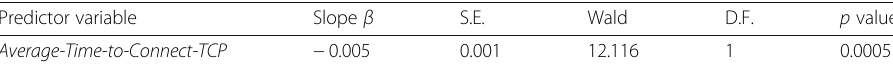
Table 6 Estimated logistic regression slope and its properties Predictor